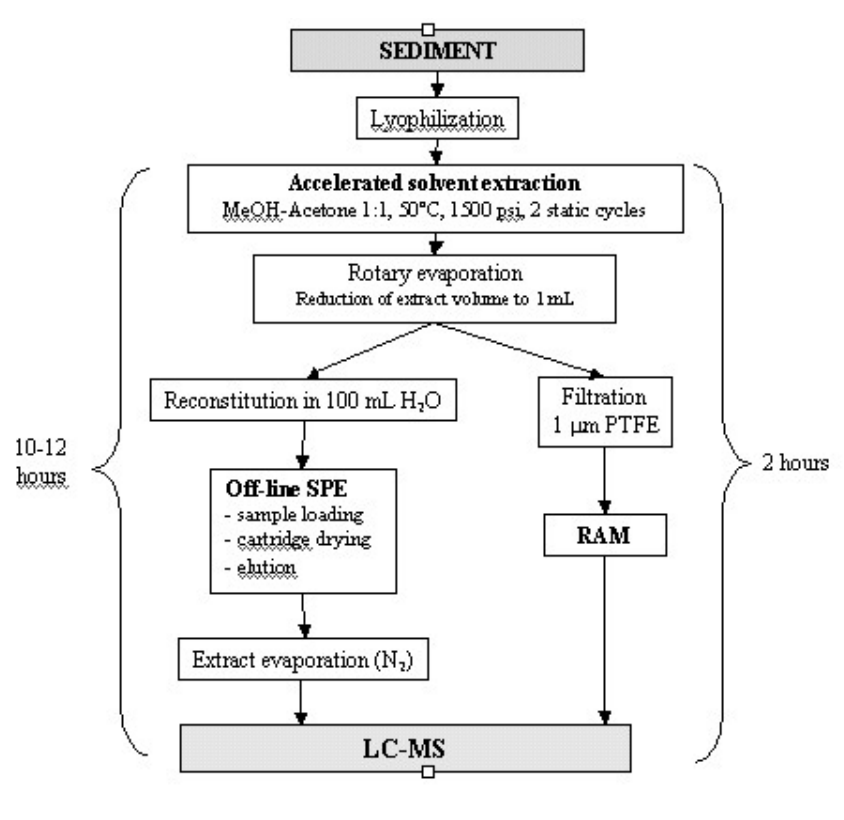
FIGURE 1 . Conventional sample preparation vs. RAM–LC integrated